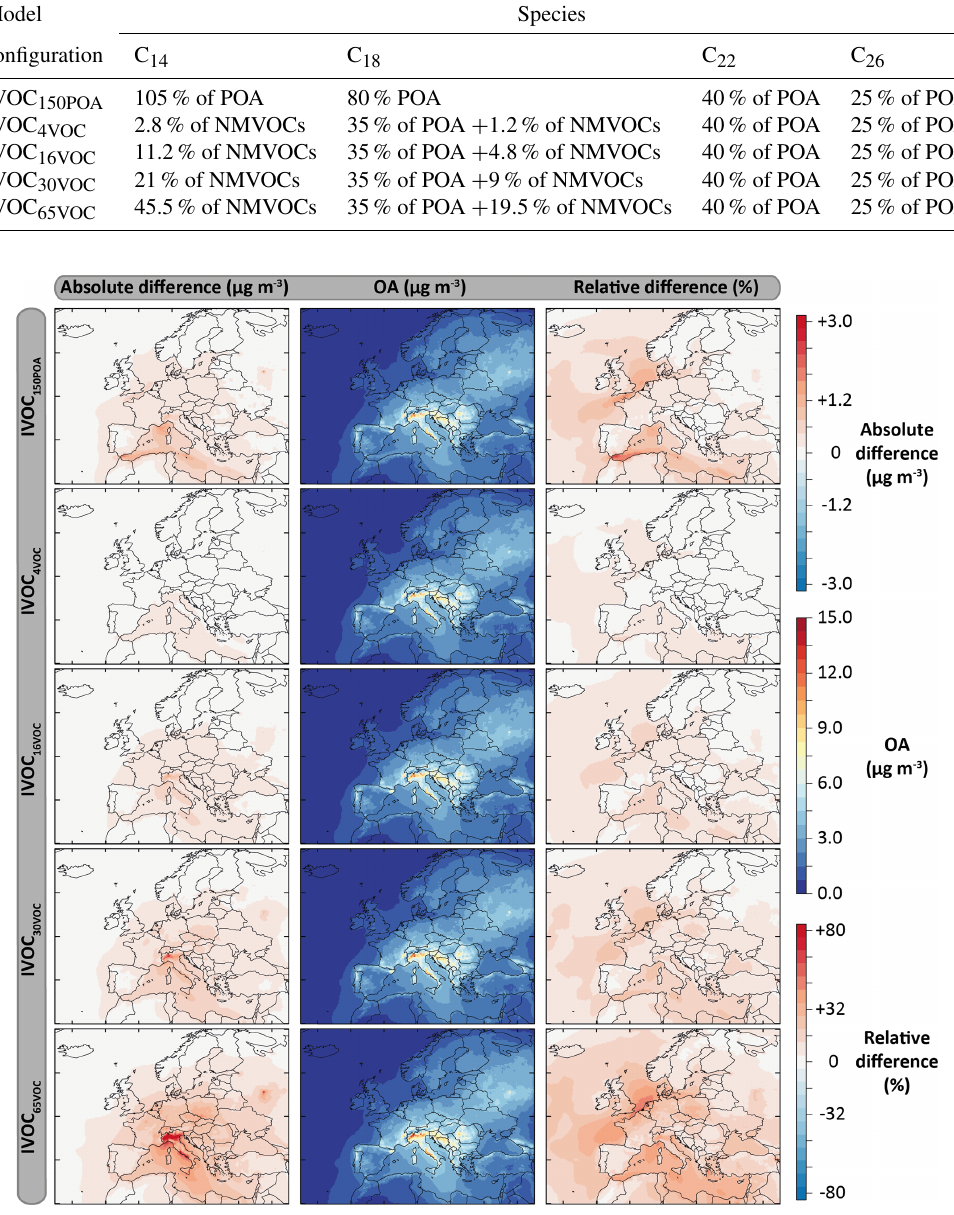
Table 5. Distribution of the VBS-GECKO surrogate species for IVOC emission in the various model configurations. Model